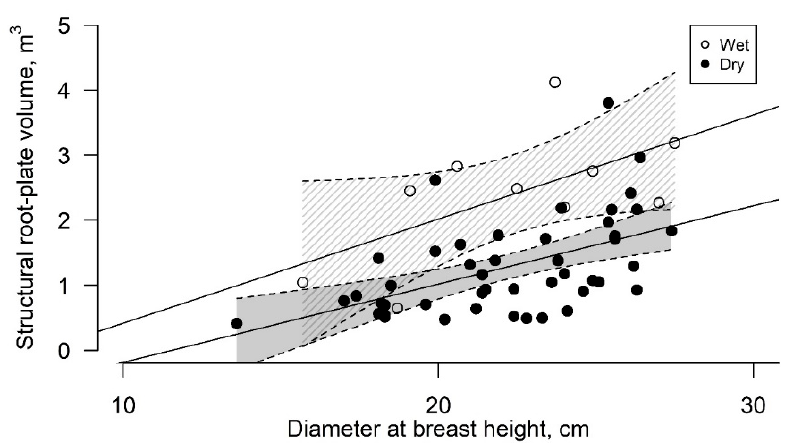
Figure 3. Root-plate volume against diameter at breast height on wet and dry mineral soils. The grey area denotes the 95% confidence interval.